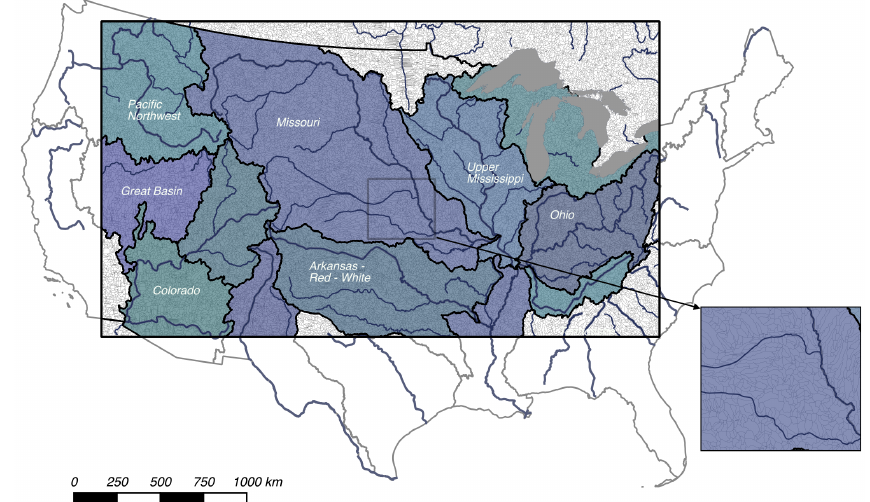
Figure 2. Map of the simulation domain extent (black box) with major river basins highlighted and labeled. Subbasins within the domain are outlined in grey. Major rivers are shown in blue for reference (note that the simulated river network is much more highly resolved, as illustrated in Maxwell et al.,